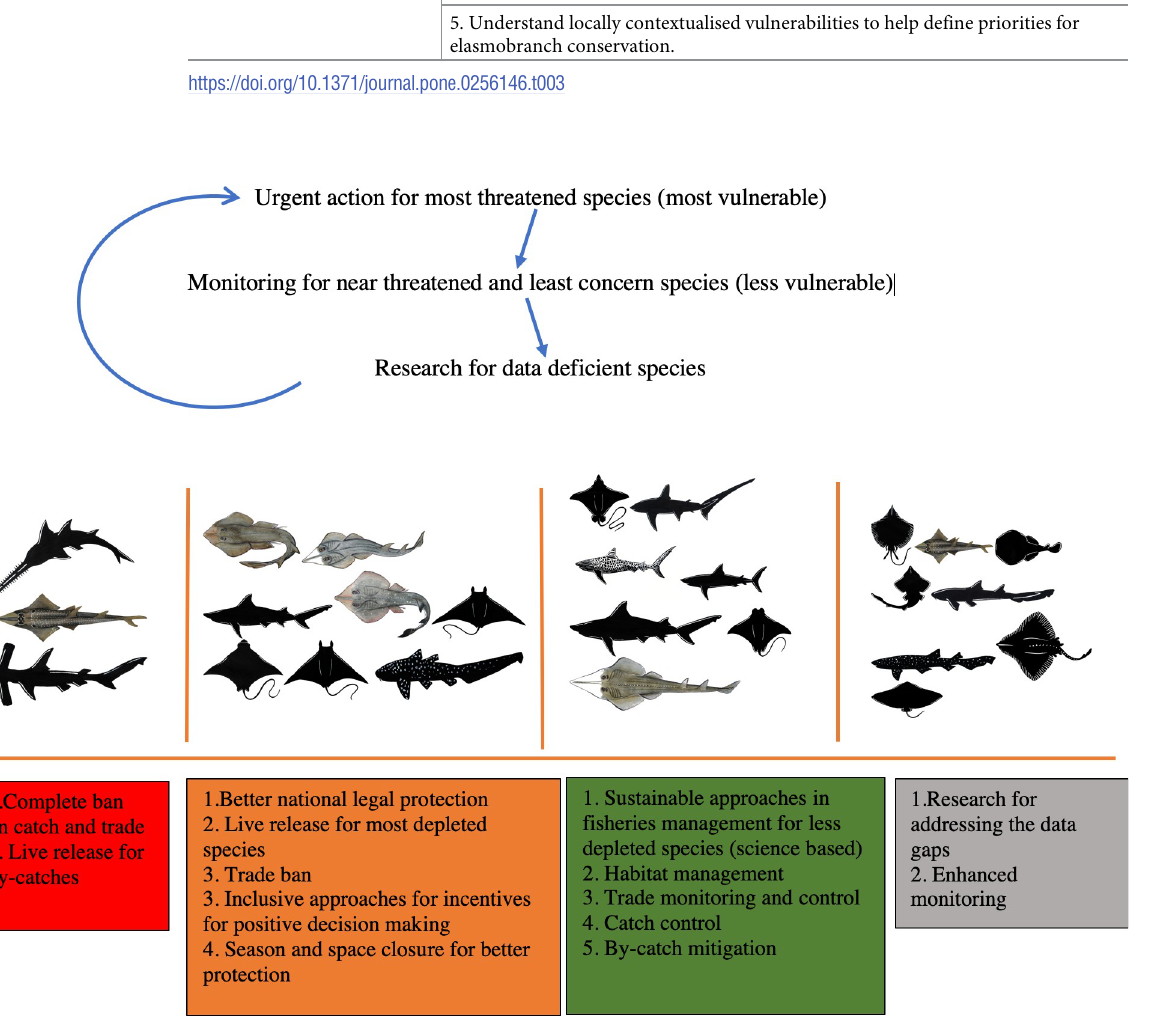
PLOS ONE | https://doi.org/10.1371/journal.pone.0256146 September 9,